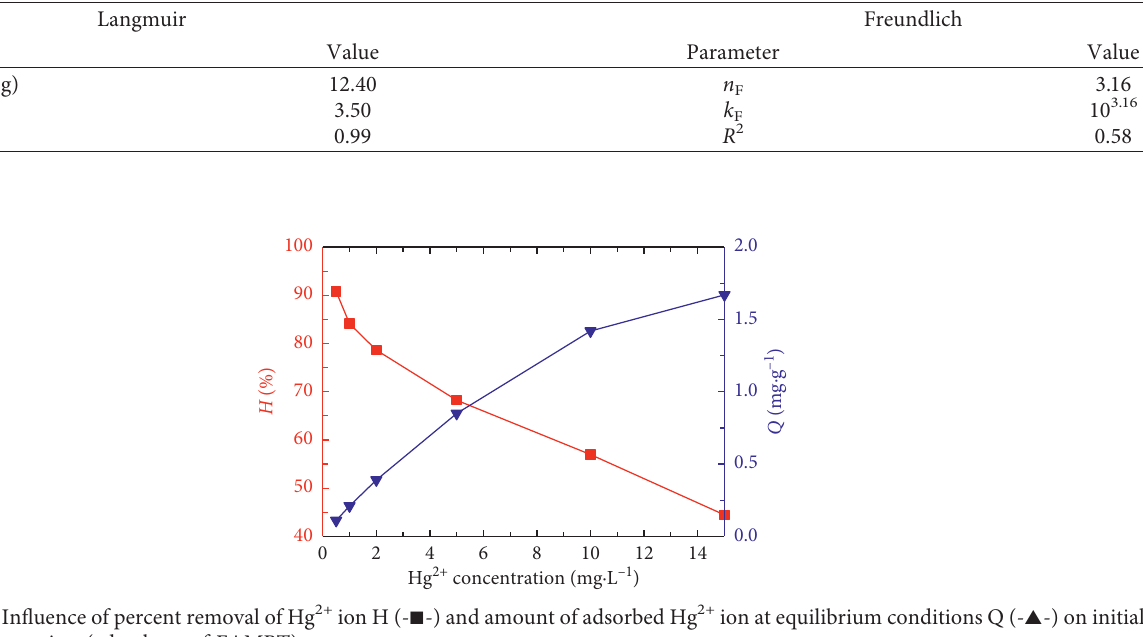
Table 5: Langmuir and Freundlich isotherm parameters reflecting Cd 2+ adsorption by the FAMBT particles.